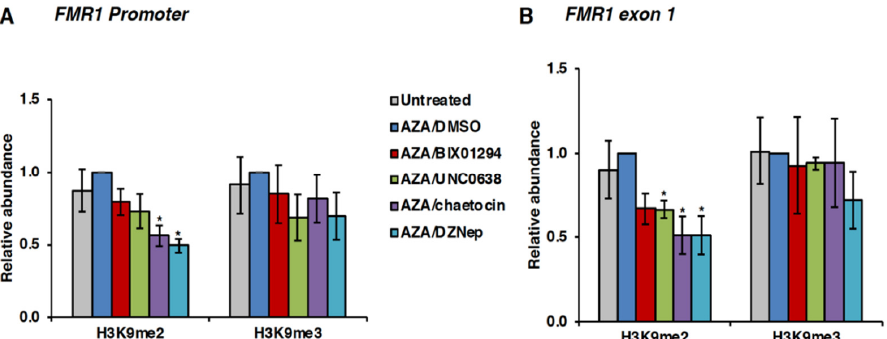
Figure 6. ( A , B ) E ff ect of HMT inhibitors on the levels of H3K9me2 and H3K9me3 on the FMR1 promoter ( A ) and exon 1 ( B ) in the FXS cell line GM04025. Cells were treated with 10 µ M AZA for 72 h